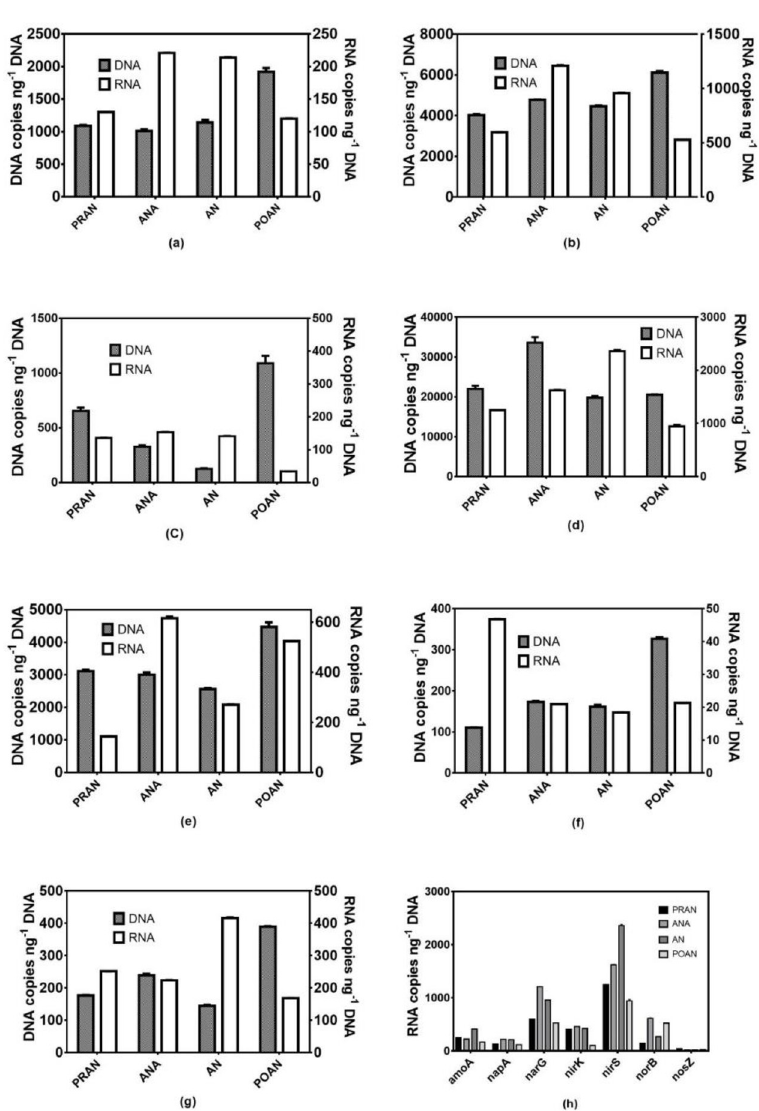
norB ; f: nosZ ; g: amoA ; h: the expression levels of nitrogen-related genes in the four denitrification